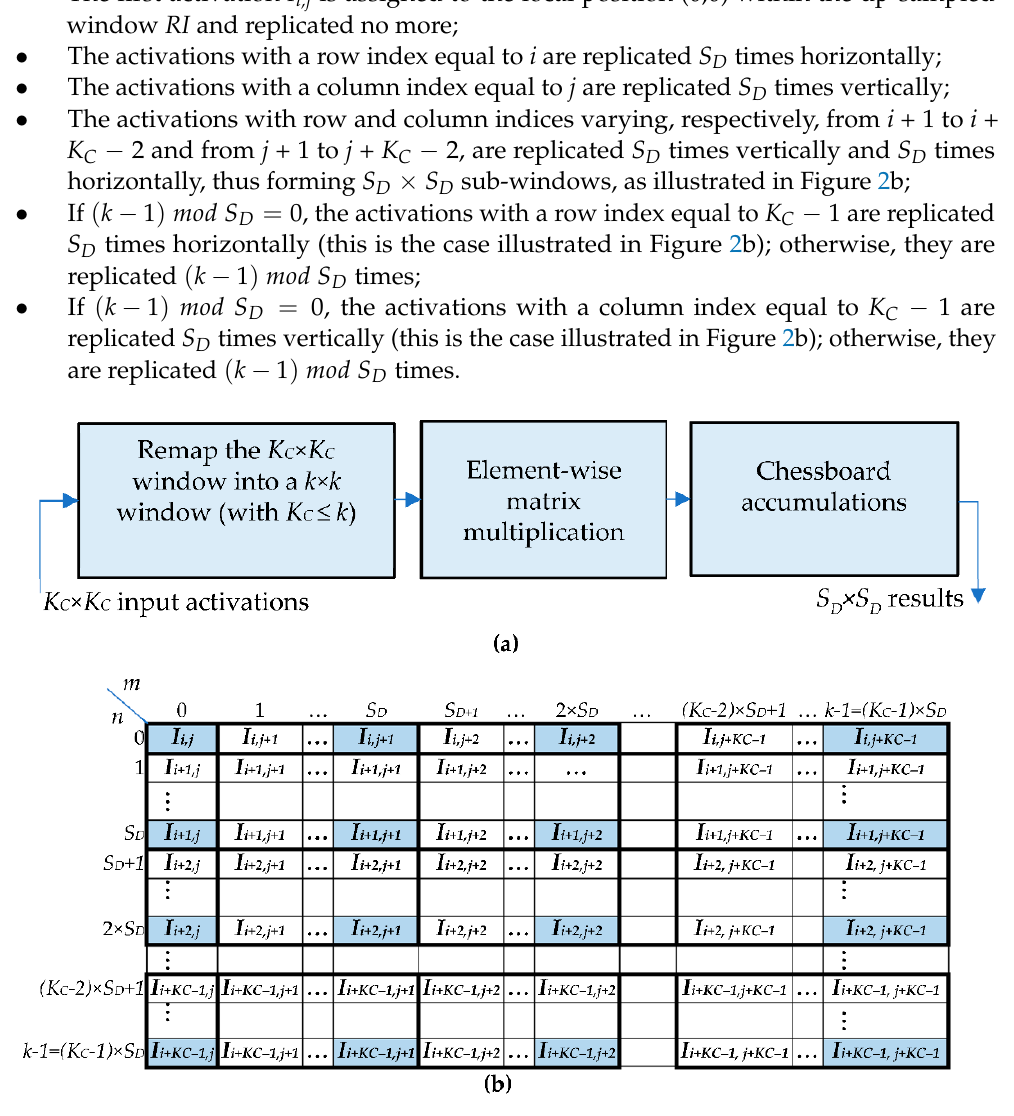
Figure 2. The novel algorithm: ( a ) The computational steps involved; ( b ) the remapping strategy. The elements of the remapped window, obtained as explained above, are multiplied by the homologous filter coefficients W m,n that do not require any type of rearrangement. Then, the computed k × k products PP m,n are properly accumulated to finally provide the S D × S D parallel results O i × S , with p and q varying from 0 to S D − 1. To D + p , j × S D + q take into account the up-sampling factor S D , the generic result O i × S must be D + p , j × S D + q computed by accumulating K C × K C products PP mm,nn picked up starting from the location mm = i × S D , nn = j × S D and going on as in a chessboard with horizontal and vertical jumps of S D positions (i.e., with stride S D ). However, it is worth noting that some jumps lead to values of mm and/or nn exceeding k , thus indexing unavailable products. Actually, referring to the ifmap currently processed as if it were up-sampled with the zero-TCONV approach, it is easy to verify that these missing products correspond to multiplications by zero. Therefore, they do not contribute to the accumulate operations and can simply be ignored. As a consequence, the results computed with the proposed strategy have the same values provided by the conventional zero-TCONV approach [18]. However, the method proposed here completely avoids multiplications by zero and filter partitioning. The software model of the proposed method is reported in Appendix